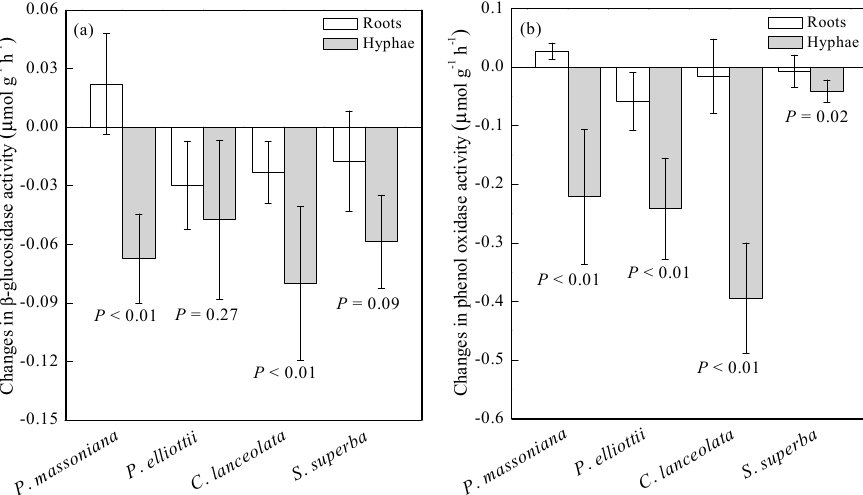
Figure 7. Changes in β -glucosidase ( a ) and phenol oxidase ( b ) activities induced by the presence of living roots (Roots) and mycorrhizal hyphae (Hyphae). p -values were obtained from linear mixed models conducted separately for each tree species, which were performed to analyze whether living roots significantly di ff ered from mycorrhizal fungi in their e ff ects on enzyme activities. Error bars represent 95% confidence intervals (CIs). When 95% CIs do not overlap with y = 0, the presence of living roots or mycorrhizal fungi significantly a ff ects enzyme